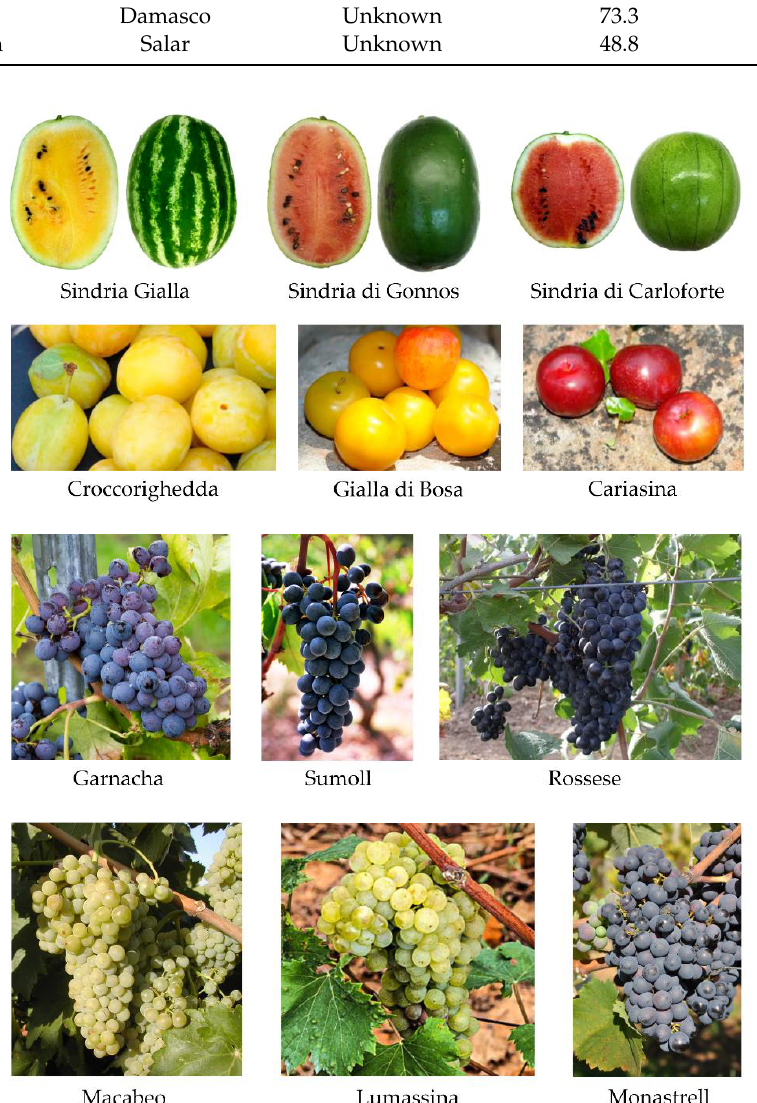
Figure 2. Selected modern cultivars with a close relationship with the archaeobotanical remains found in the Medieval well of Sassari.